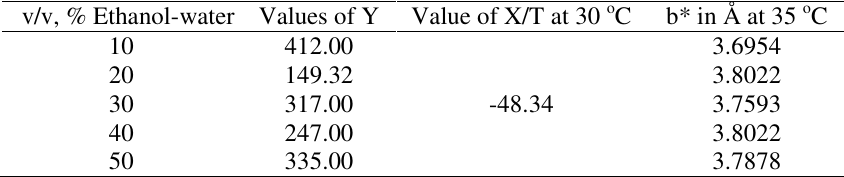
Table 2. Values of X, Y and b* in water-ethanol